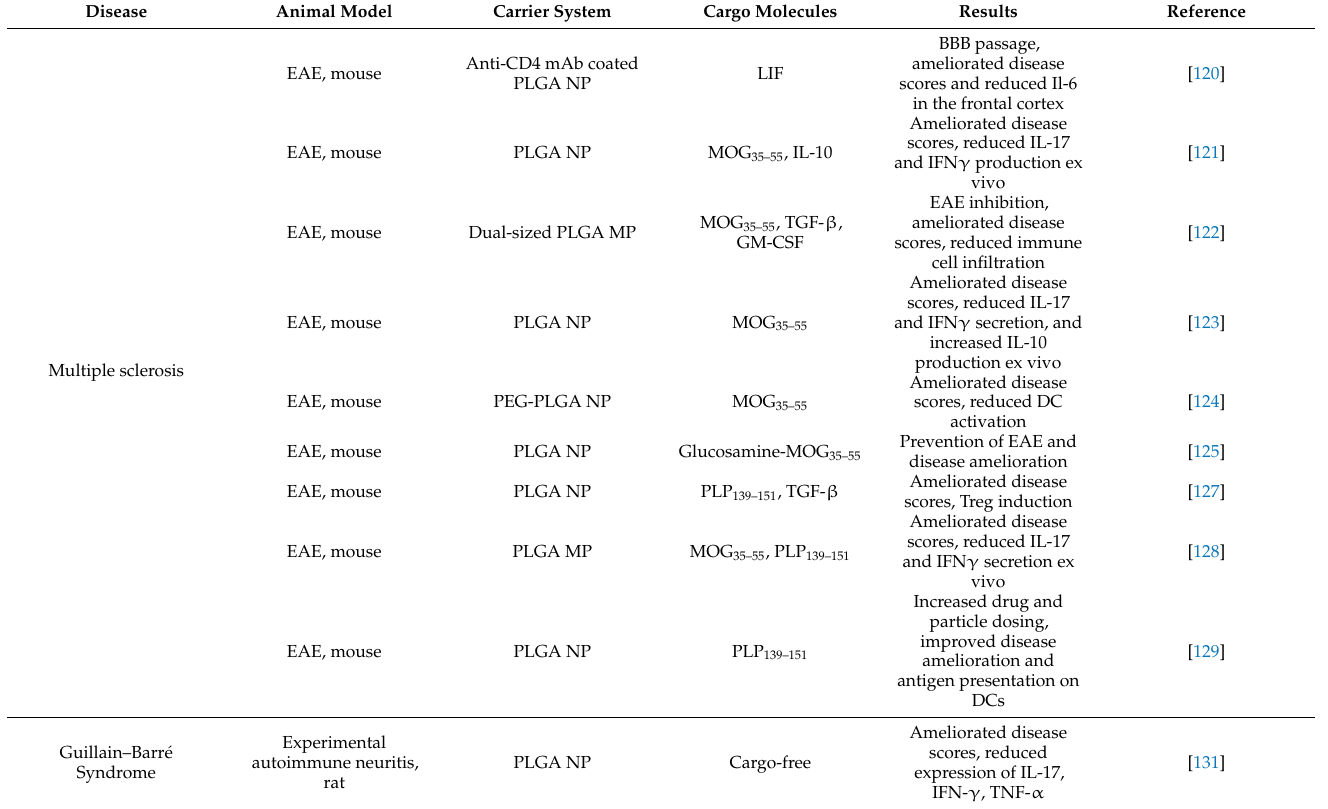
Table 3. Summary of PLGA mediated immunotherapy of